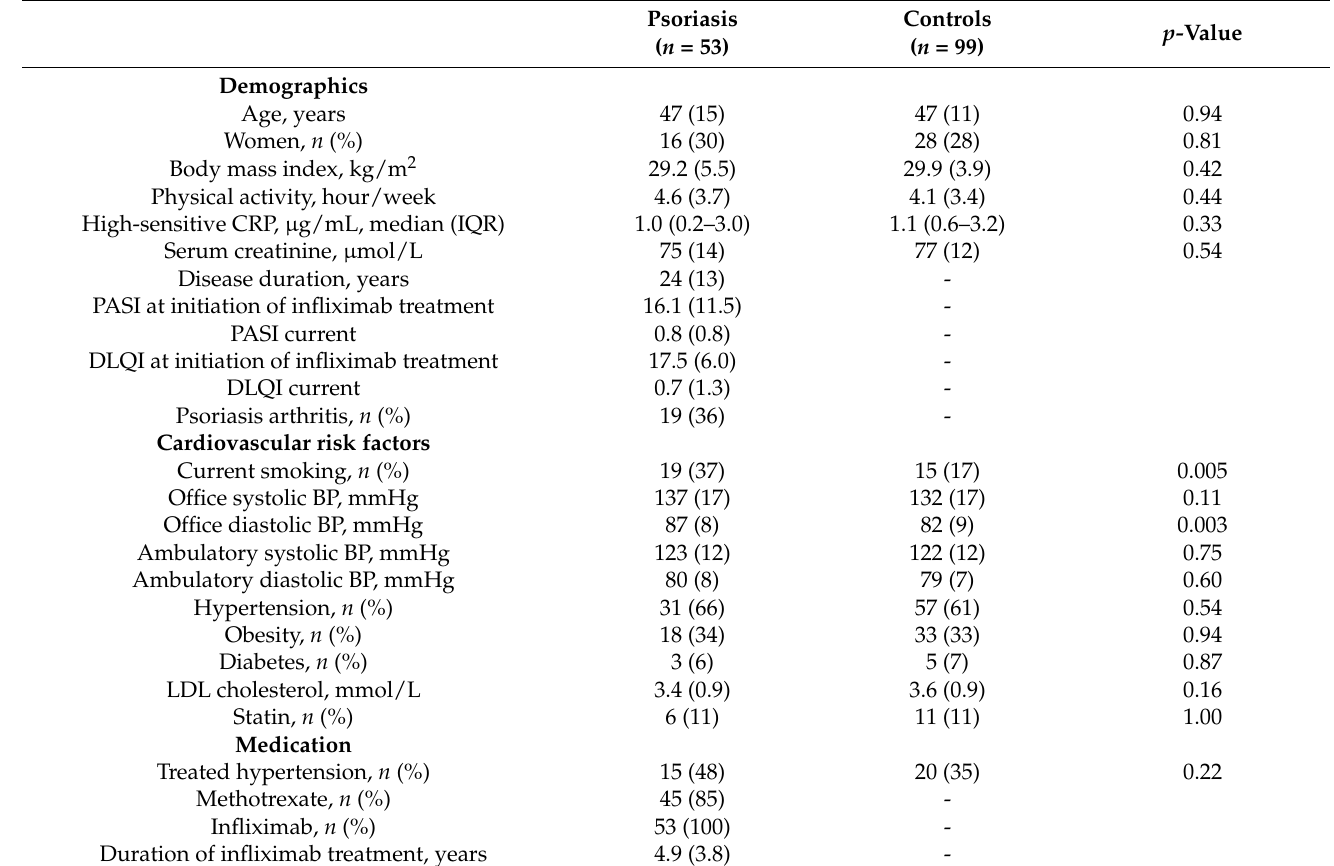
Table 1. Clinical characteristics of psoriasis patients and